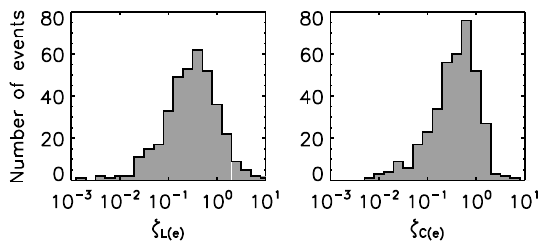
Figure 4. Histogram of electron Landau resonance parameter ζ L(e) (left panel) and cyclotron resonance parameter ζ C(e)